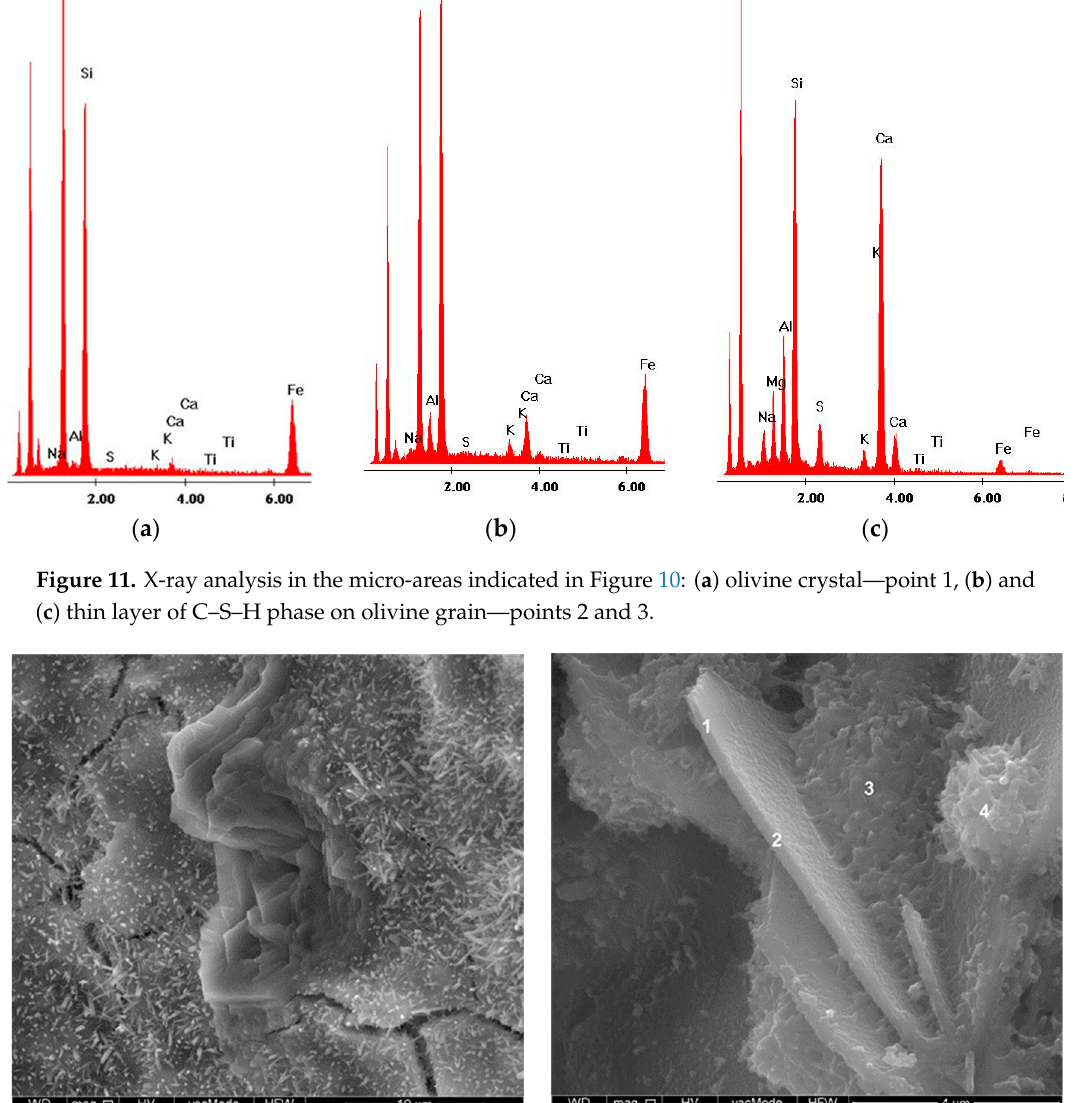
Figure 11. X-ray analysis in the micro-areas indicated in Figure 10: ( a ) olivine crystal—point 1, ( b ) and ( c ) thin layer of C–S–H phase on olivine grain—points 2 and 3.